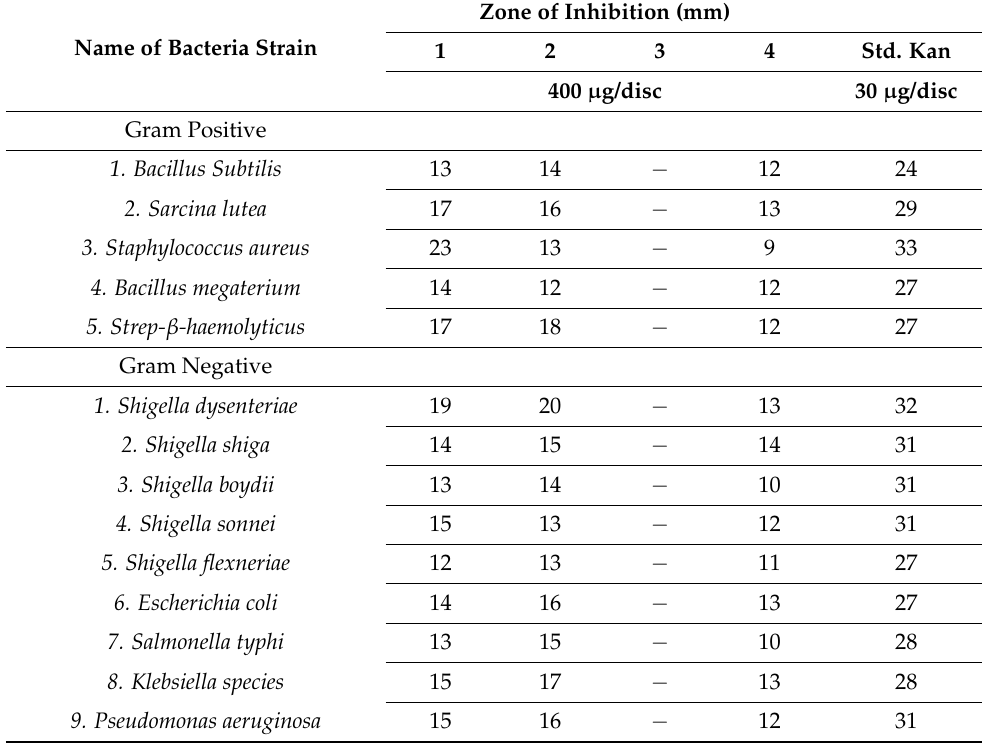
Table 1. Antibacterial activity of the compounds 1 – 4 and standard kanamycin.